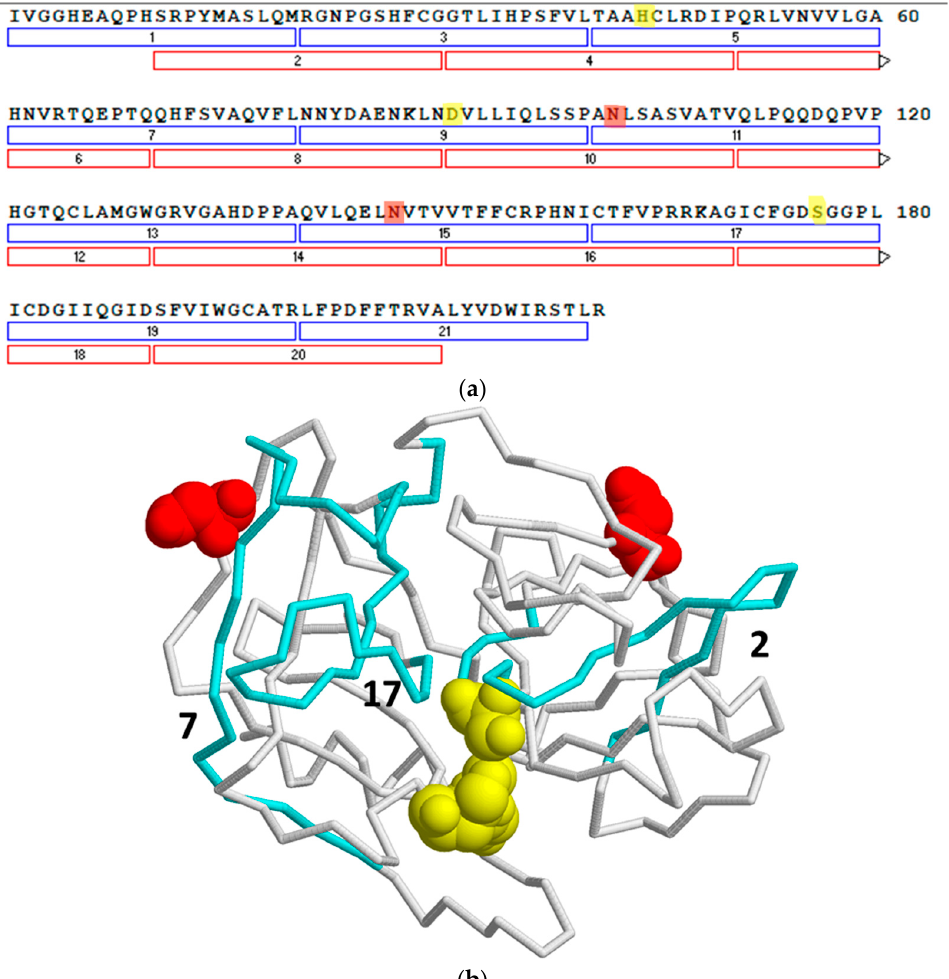
Figure 16. Amino acid sequence and three-dimensional model of human PR3. ( a ). The amino acid sequence of active human PR3 (Uniprot accession number P24158) with the 21 synthesized overlapping peptides indicated with bars and numbers. The three amino acids making up the catalytic triad (His57, Asp102 and Ser195) are shown in a space fill model and marked in yellow, while the two glycosylated asparagine’s are shown in red. ( b ). Three-dimensional structure of PR3 (PDB 1FUJ) shown in backbone view. The catalytic site and glycosylated asparagine’s are shown in space-fill mode and colored like in the sequence. The active catalytic center is in the cleft between the two major domains 1 and 2. By comparing figure ( a , b ) it can be seen that peptide 2, 7 and 17 (marked in cyan) are surface-accessible, close in space, and in proximity of the active site.